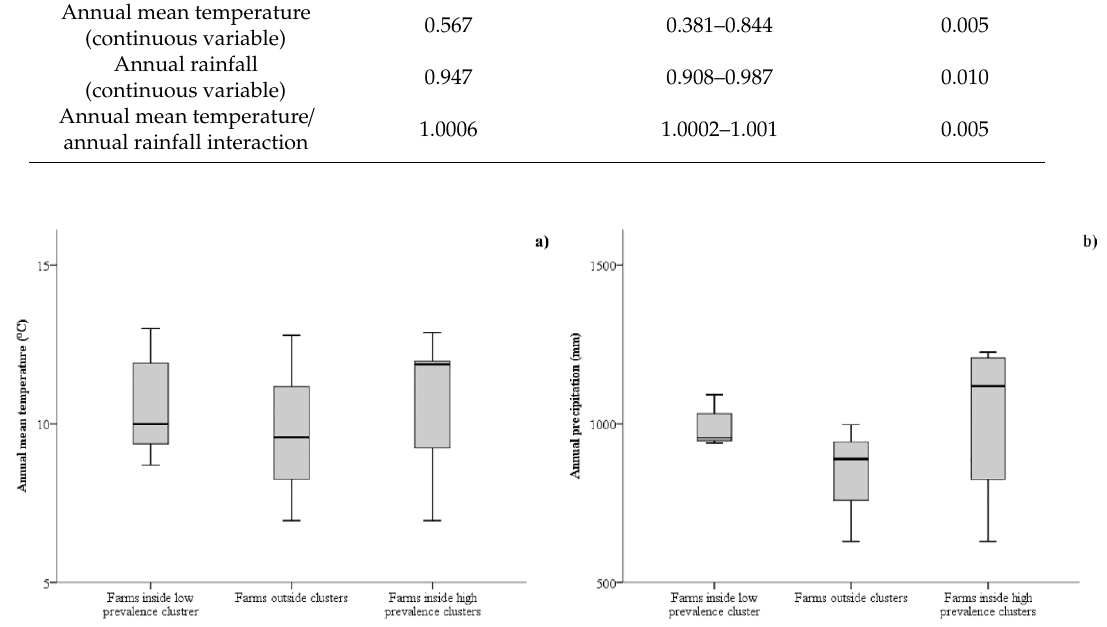
Figure 6. Annual mean temperature ( a ) and annual rainfall ( b ) in sheep farms sited inside the low N. caninum prevalence cluster, outside clusters, and inside the high N. caninum prevalence clusters. Table 4. Risk factors associated with higher Neospora caninum prevalence in sheep farms using multivariate multilevel modeling.